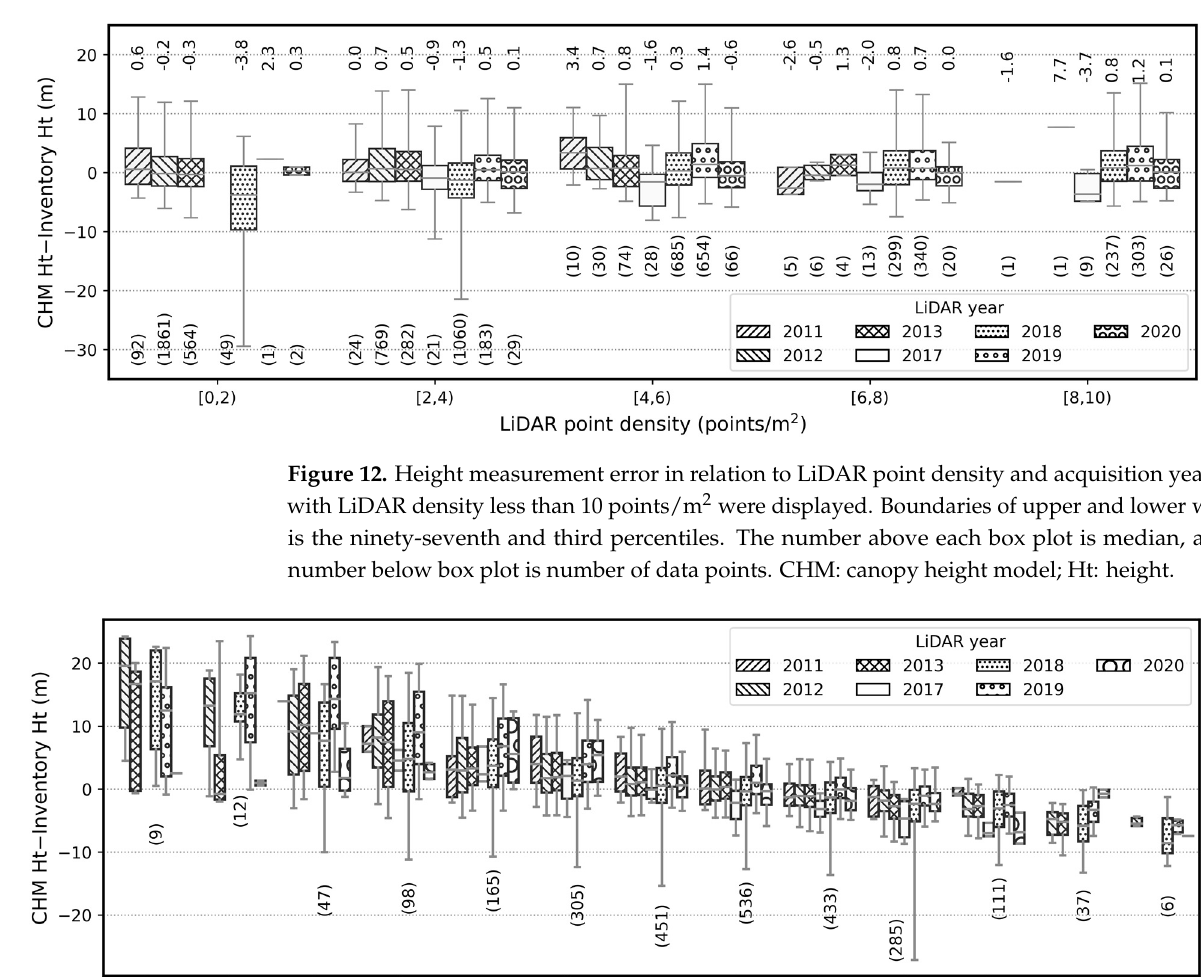
Figure 13. Height measurement error with respect to inventory height and LiDAR data acquisition year. Boundaries of upper and lower whisker is the 97th and 3rd percentiles. The number below box plot is number of data points of 2018 LiDAR data. CHM: canopy height model; Ht: height.